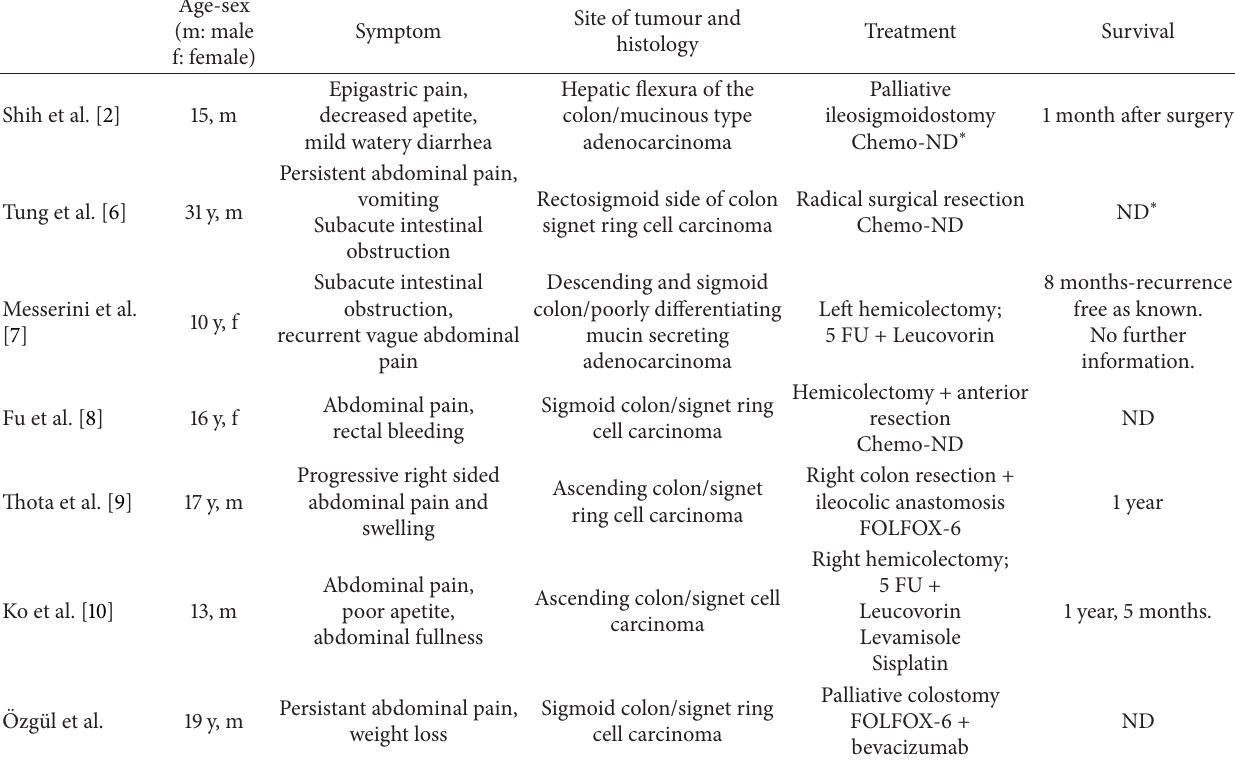
Table 1: Reported cases with colon cancer in young